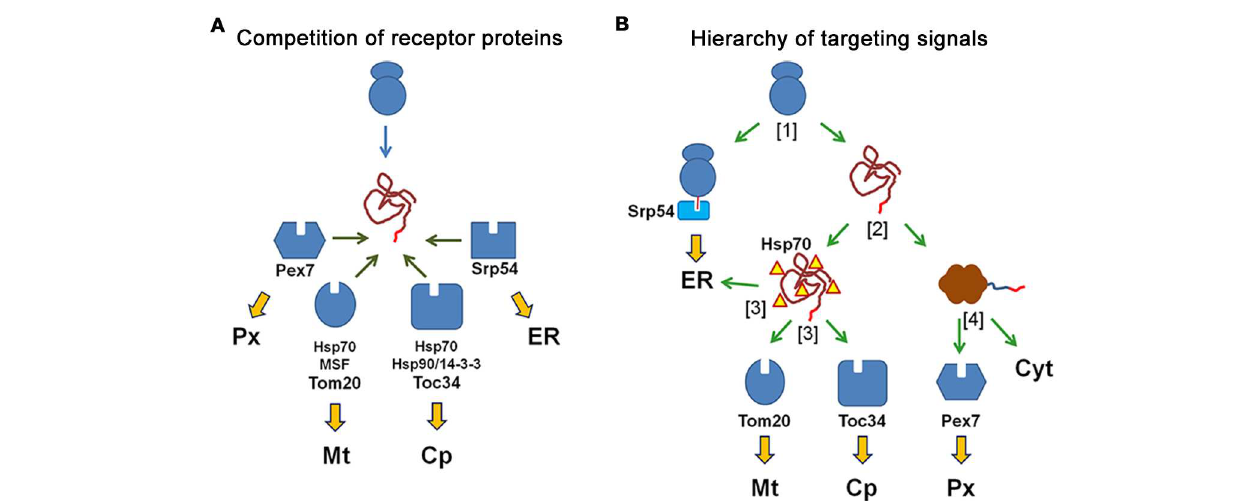
FIGURE 3 | N-terminal targeting signals determine the transport route of proteins by the interaction with the receptor proteins. (A) Competition of receptor proteins : the N-terminal amino acid sequence of a newly synthesized protein can interact with all receptor proteins, which compete for the peptide sequence (peroxisomal Pex7, mitochondrial Tom20, chloroplast Toc34, and Srp54 for the ER) and with additional cytosolic proteins that might affect these interactions (Hsp70, Hsp90, 14-3-3 proteins). The choice of the transport route is based on the relative affinity of the peptide sequence to different receptor proteins. (B) Different import mechanisms generate a hierarchy of targeting signals : An N-terminal amino acid sequence is sequentially scanned by diverse receptor proteins, because these interactions occur at different time points during the production and folding of the protein. A newly synthesized protein either binds to the SRP to become translated into ER or it finishes translation in the cytosol [1] Next, the protein either becomes folded or remains unfolded due to its interaction with chaperones, [2] Unfolded proteins can interact with the mitochondrial receptor Tom20, the chloroplast receptor Toc34 or the Sec61 complex of the ER (translocon), [3] Finally, folded proteins can either interact with the soluble receptor protein Pex7, which initiates their transport into peroxisomes, or they remain in the cytosol [4].